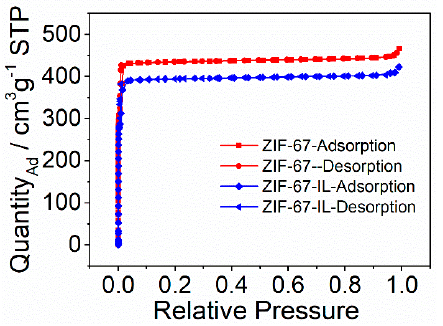
Figure 4. SEM images of ZIF-67 ( a ) and ZIF-67-IL ( b ).